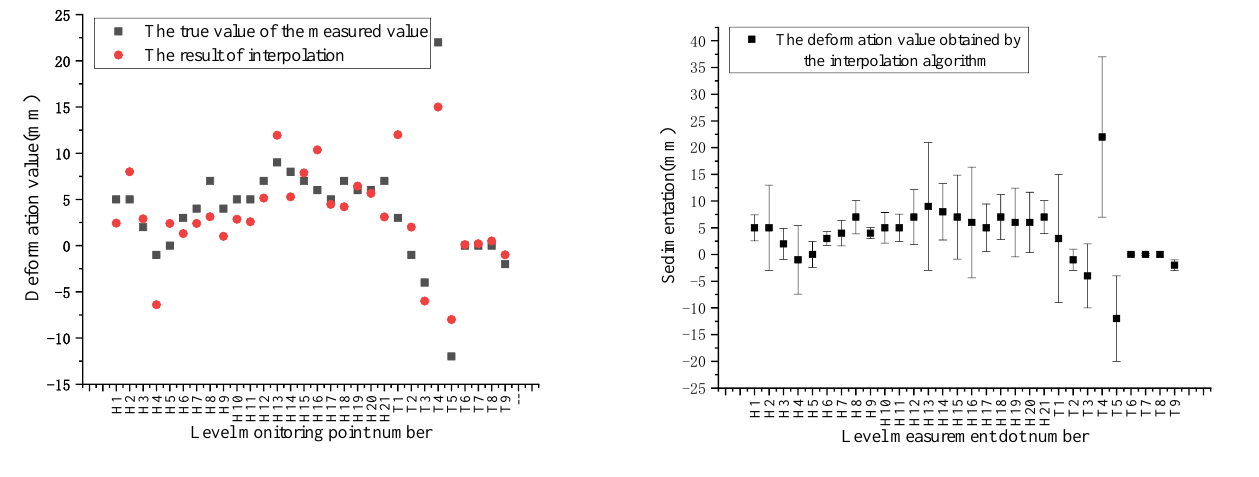
Figure 21. Comparison of real values and interpolation results of level monitoring points on seawall road and soil embankment road (Figure right) error.